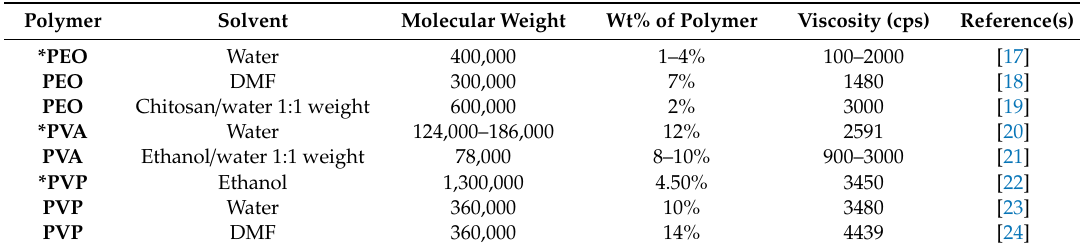
Table 2. Comparison study of spinnable polymers based on solvent and